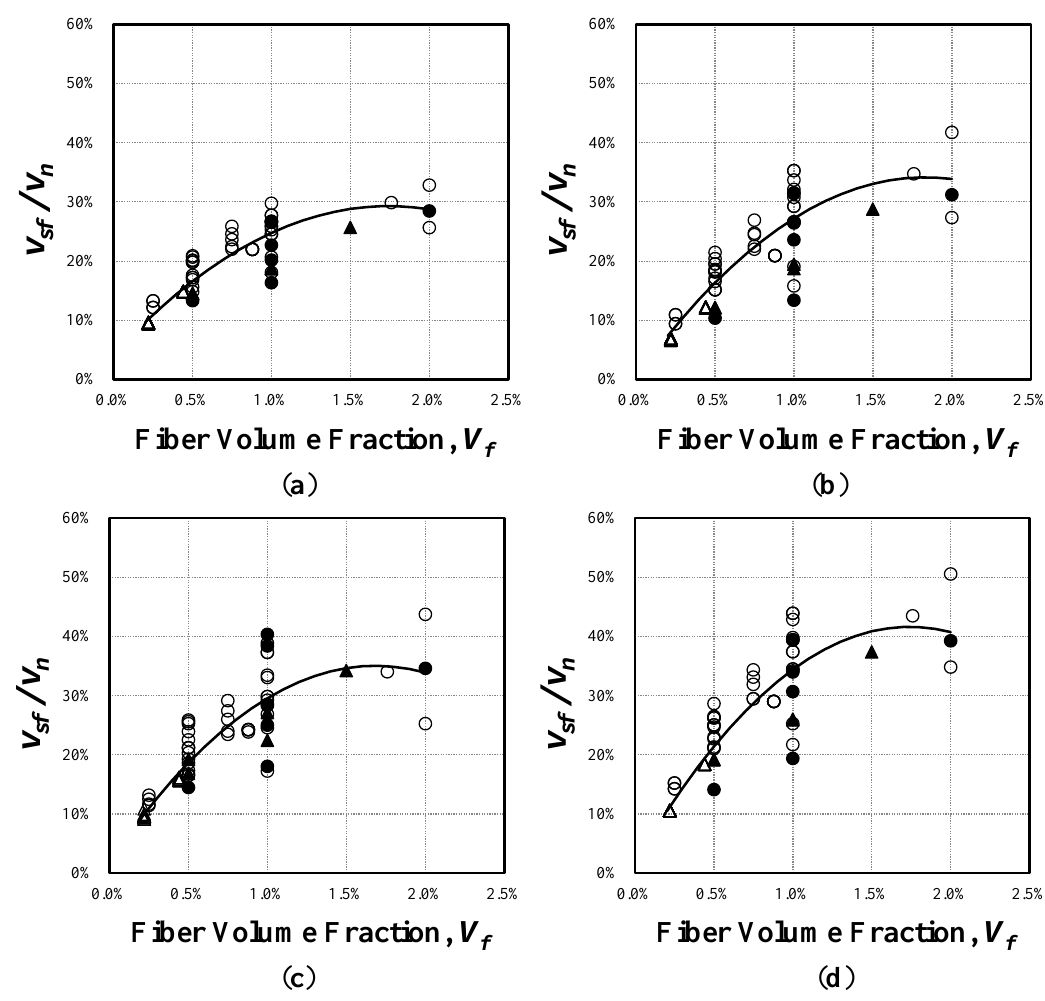
Figure 6. Contribution of steel fibers to shear strength at failure. ( a ) The modified RA-STM with steel fibers; ( b ) The modified FA-STM with steel fibers; ( c ) The modified TATM with steel fibers; ( d ) The modified SMM with steel fibers. ●: a / d < 4;